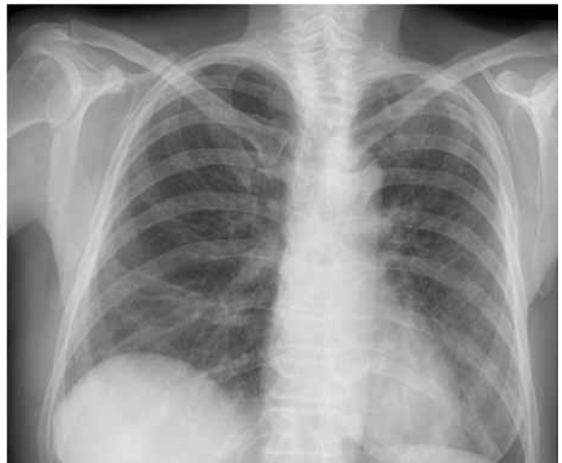
Figure 2. Standing posteroanterior chest x-ray of patient with polymyositis: history of